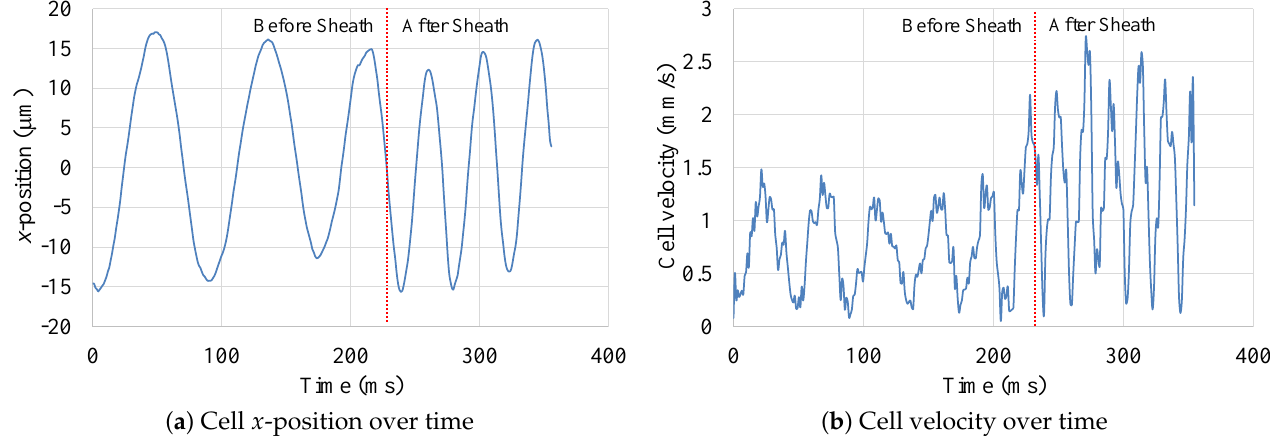
Figure 9. Effect of sheath flow on MCF-10A cell velocity. Cell mean velocity increased by